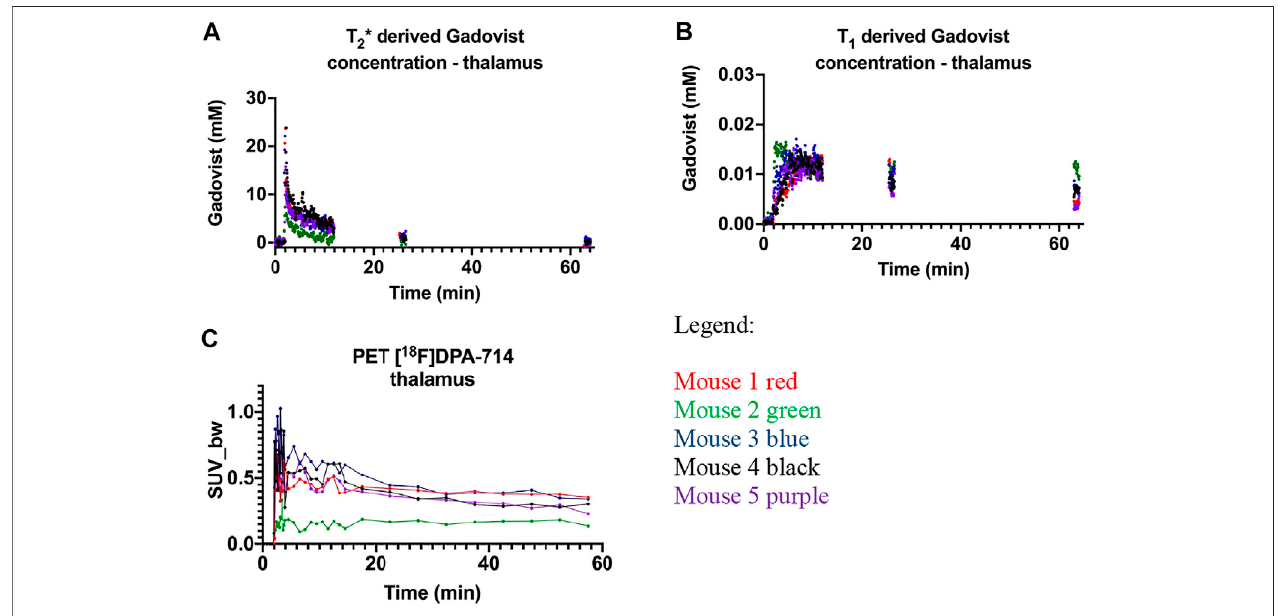
FIGURE 2 | Gadovist thalamus derived concentration derived from the changes in: (A) T 2 *; (B) T 1 ; (C) thalamus time activity curve representing the uptake of [ 18 F] DPA-714 as standard uptake value normalised to body weight (SUV-BW). Mouse 1-red, mouse 2-green, mouse 3-blue, mouse 4 black and mouse 5-purple.